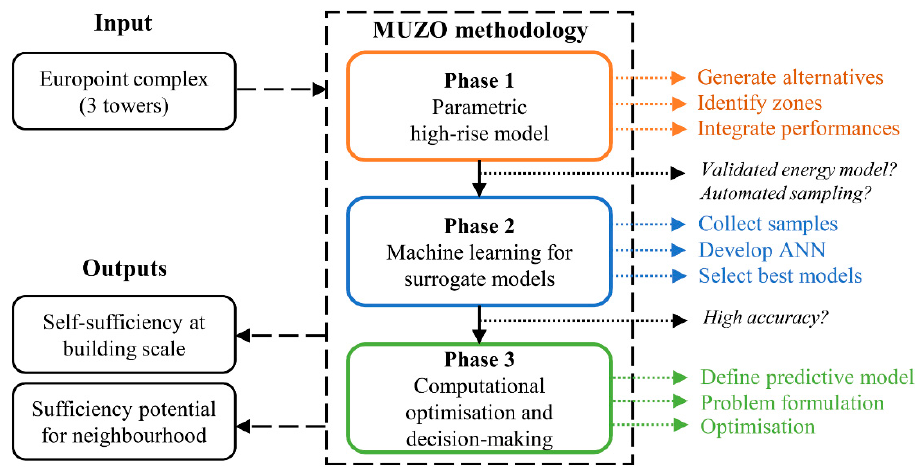
Figure 1. Utilisation of MUZO methodology for the self-sufficient Europoint complex.